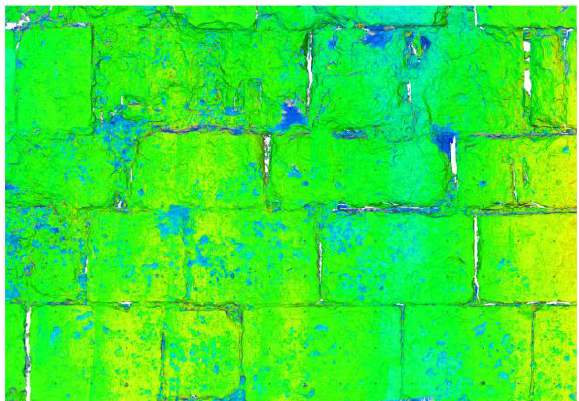
Figure 11. Trial area 3 at Santa Maria de Vitoria. 3D- Comparison of 2016 and 2017. Green: stable surface +/- 0.15 mm; yellow to red: growth up to +1 mm; turquoise to blue: loss up to -25 mm